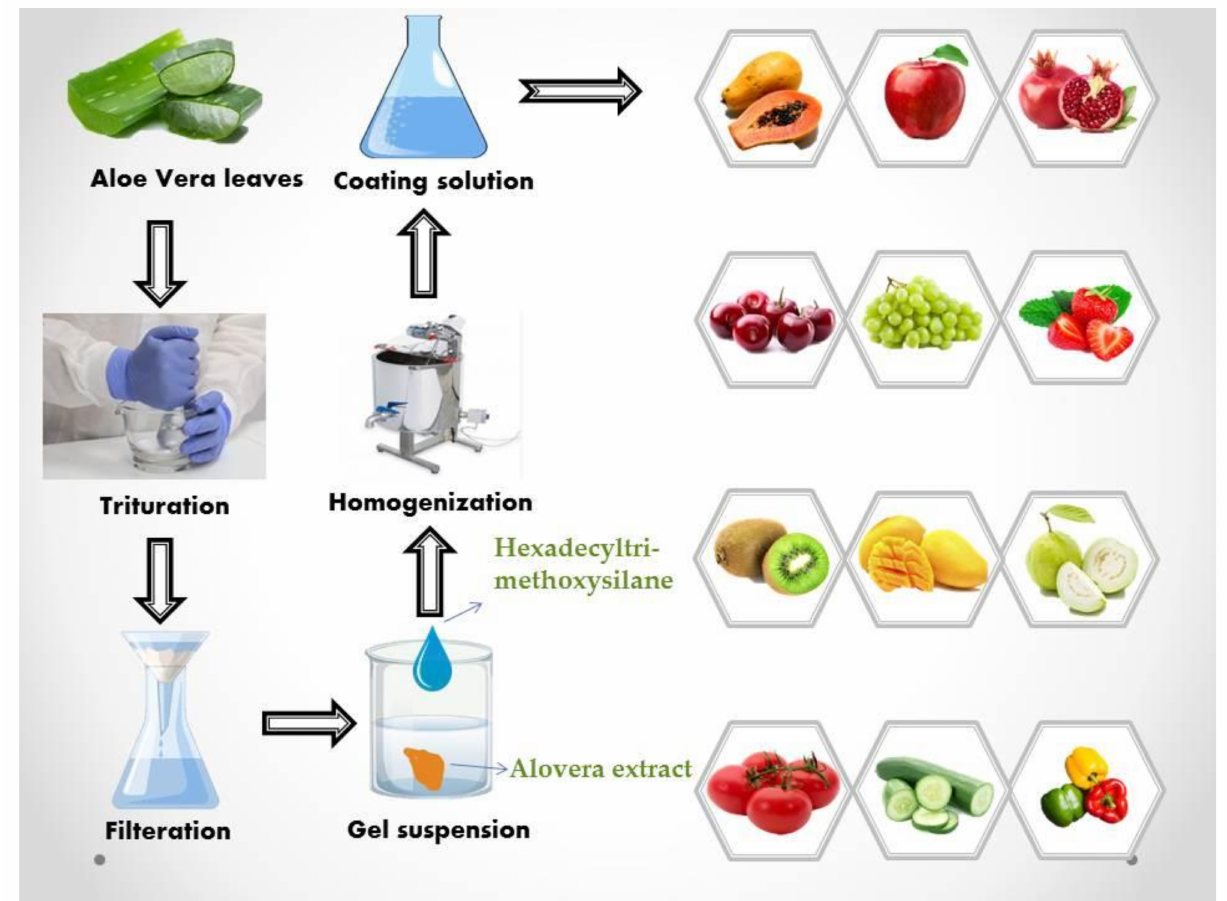
Figure 1. Aloe vera extract as a spraying